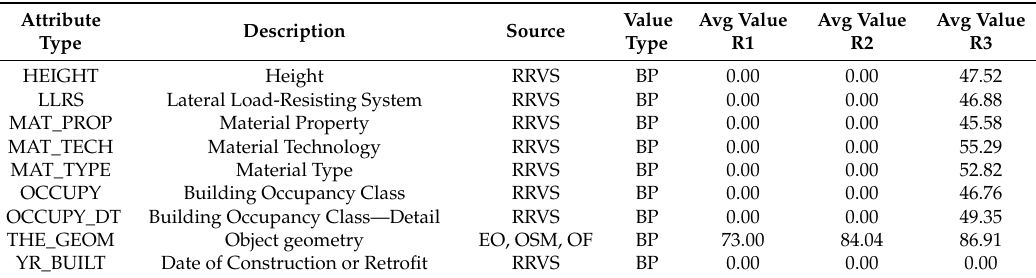
Table 1. Excerpt of a dynamically created meta-data summary table that summarizes the currently available attributes, their sources, and the evolution of their average value (here degree of belief in percent) from release R1 to